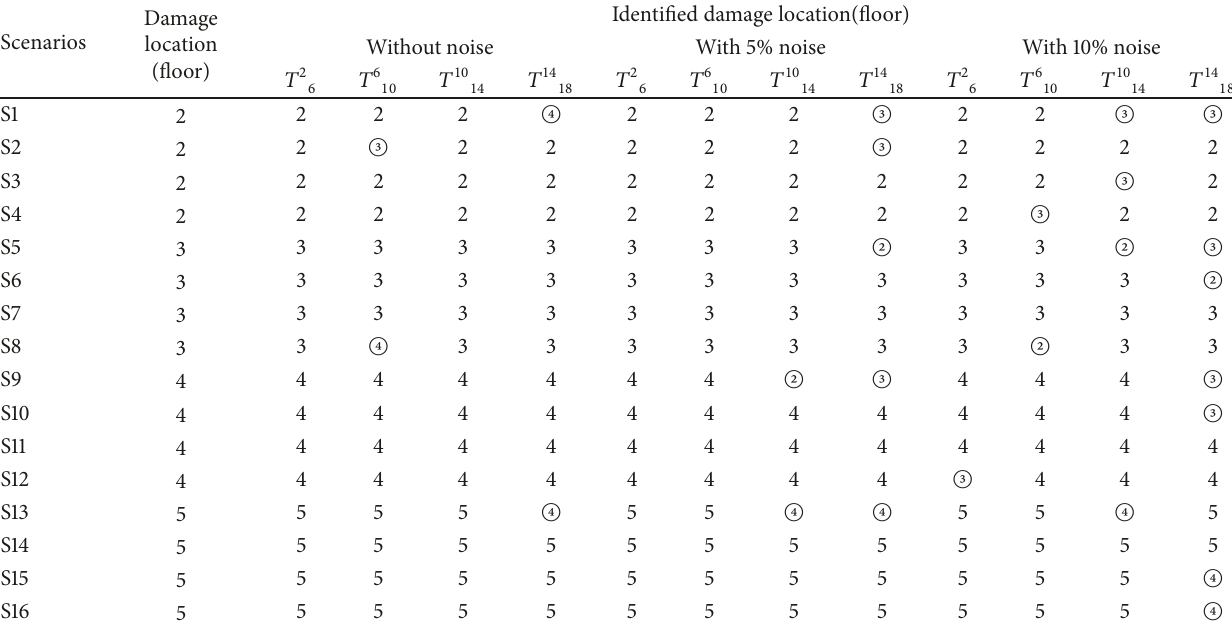
Table 3: Identified damage locations based on WPEV and SVM.